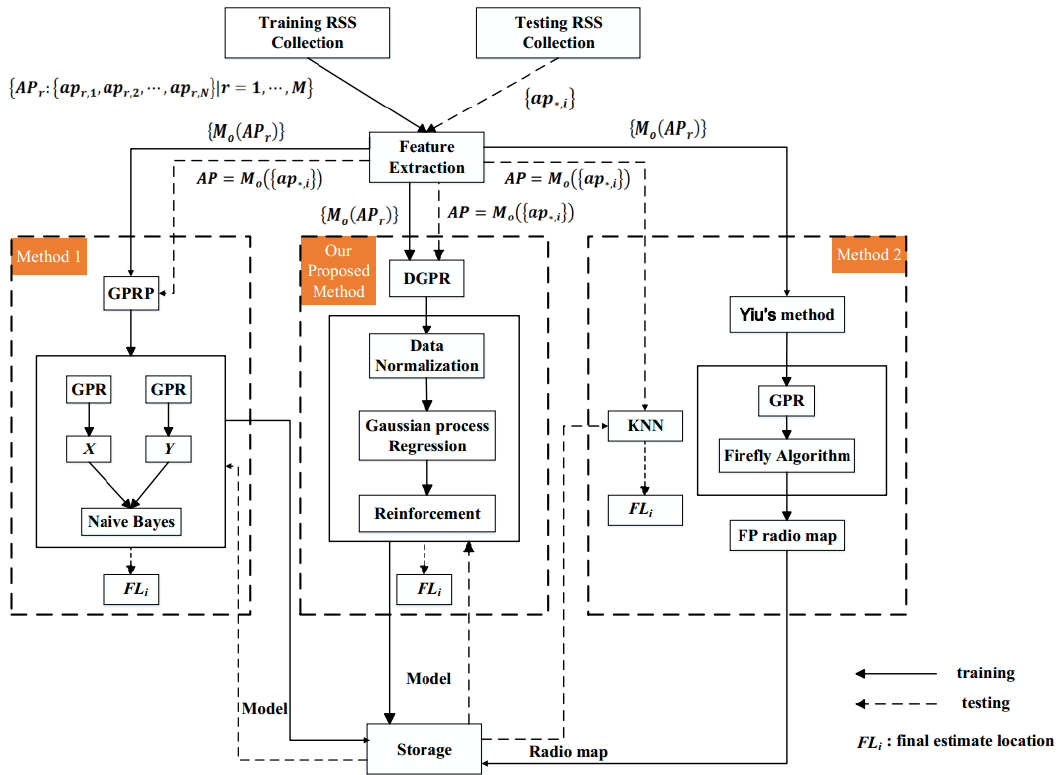
Figure 2. Comparison of frameworks of Deep Gaussian Process Regression Model (DGPR) method and